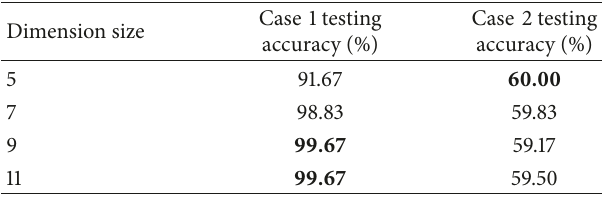
Table 17: Bearing fault diagnosis results obtained by the OFS-LDA-